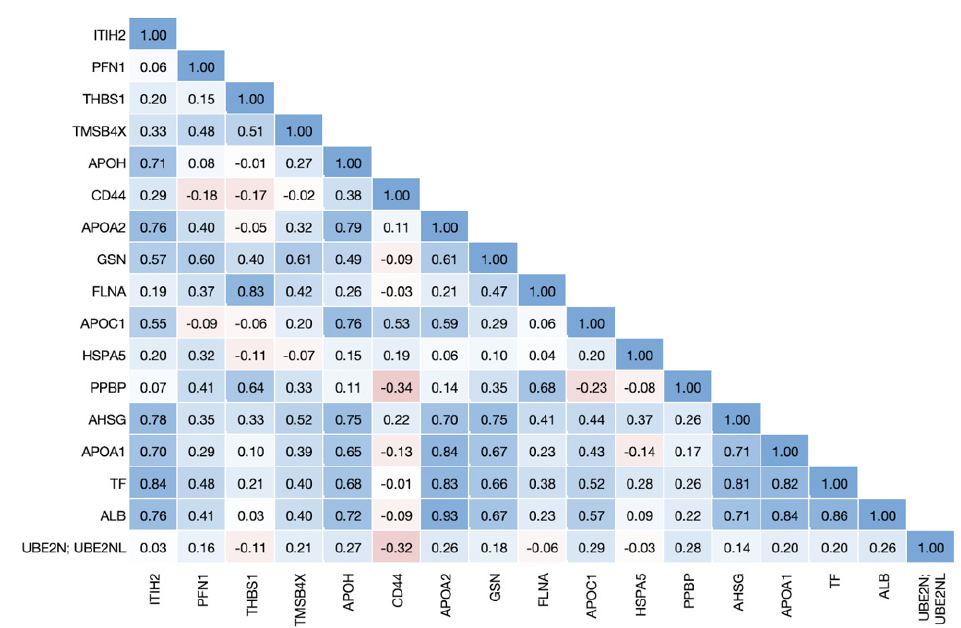
Figure 1. Correlation matrix of proteins upregulated in COVID-19 disease states. Proteins that were upregulated in non-severe and severe COVID-19 in the [9] dataset or upregulated in COVID-19 in the [8] dataset were identified in the erythrocyte dataset and Pearson correlations were calculated among all proteins.